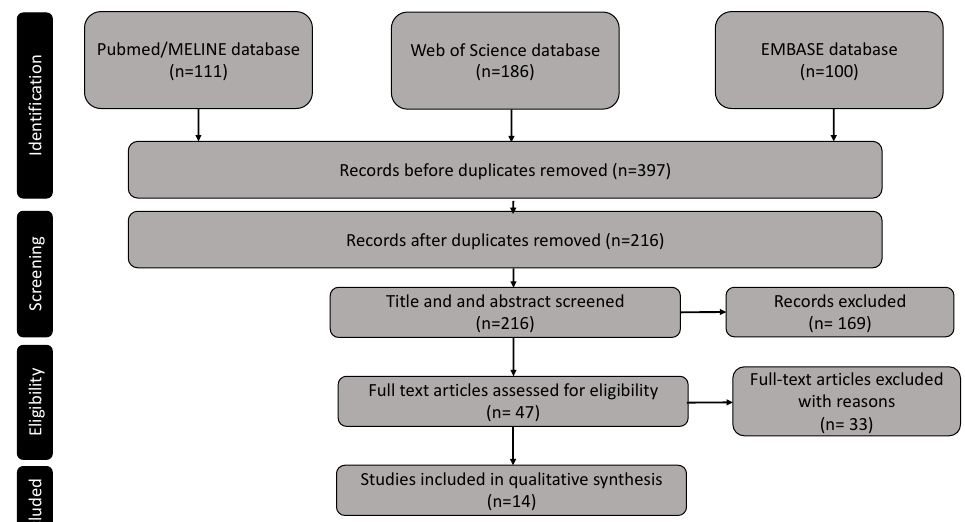
Figure 3. Flow chart depicting the selection process.